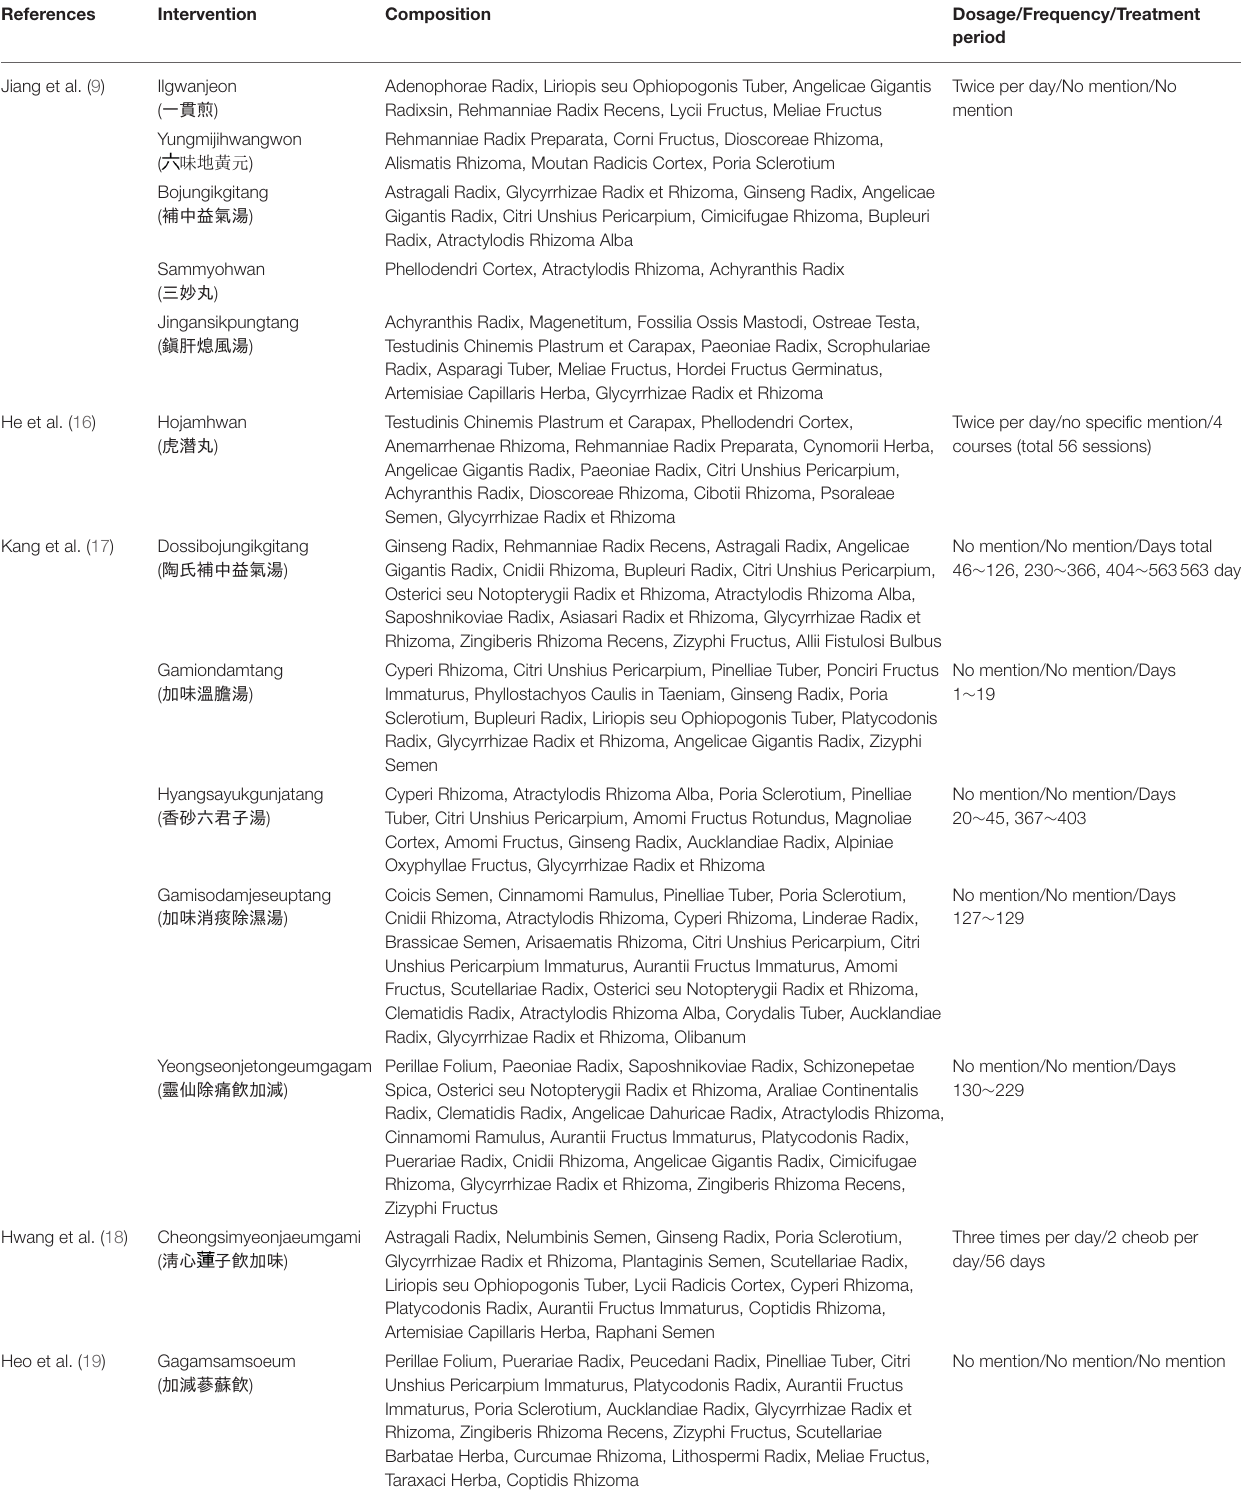
TABLE 4 | Summary of the compositions and dosages of herbal medicine in the included